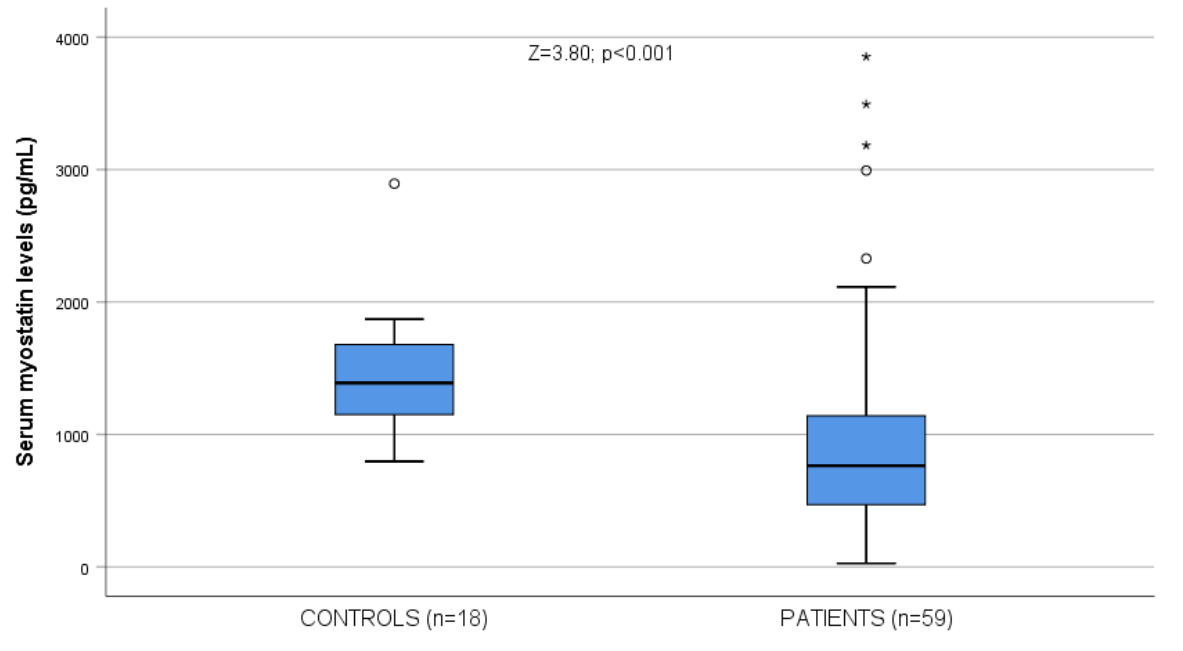
Figure 1. Serum myostatin levels in patients (n = 59) and controls (n = 18). Circles correspond to outliers, and asterisks correspond to extreme outliers.